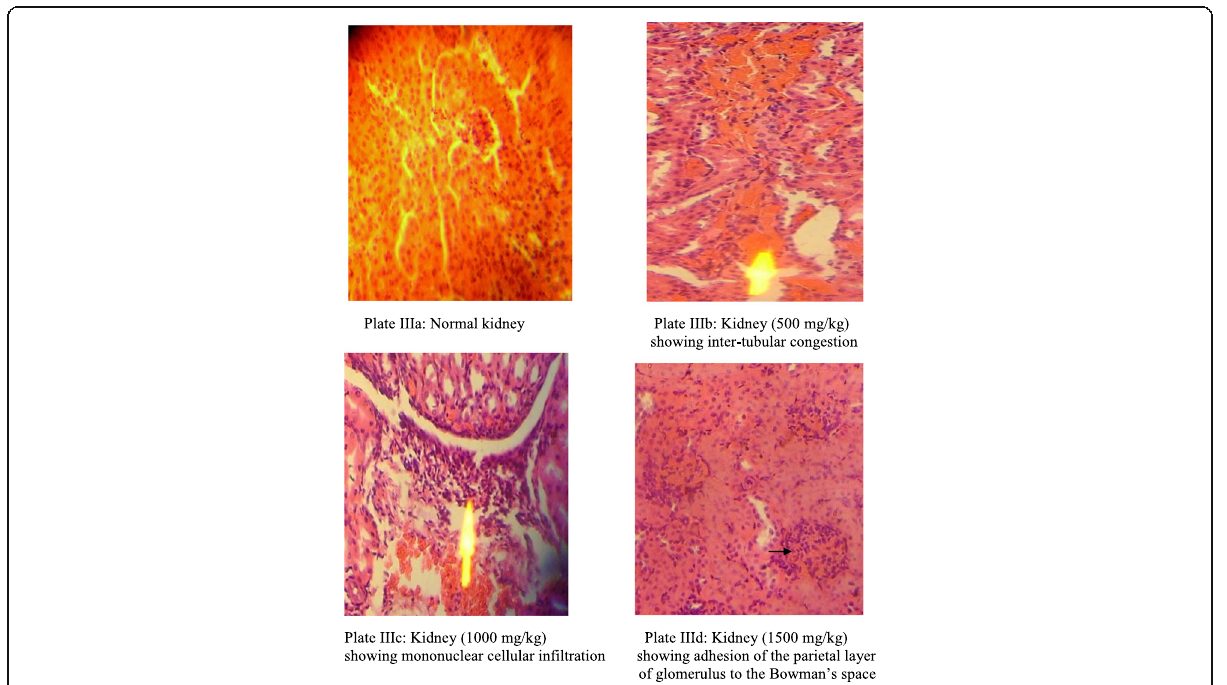
Fig. 3 Photomicrograph of the kidney of rats administered aqueous extract of Spondias purpurea leaf (H and E × 200). a Normal kidney. b Kidney (500 mg/kg) showing inter-tubular congestion. c Kidney (1000 mg/kg) showing mononuclear cellular infiltration. d Kidney (1500 mg/kg) showing adhesion of the parietal layer of glomerulus to the Bowman ’ s